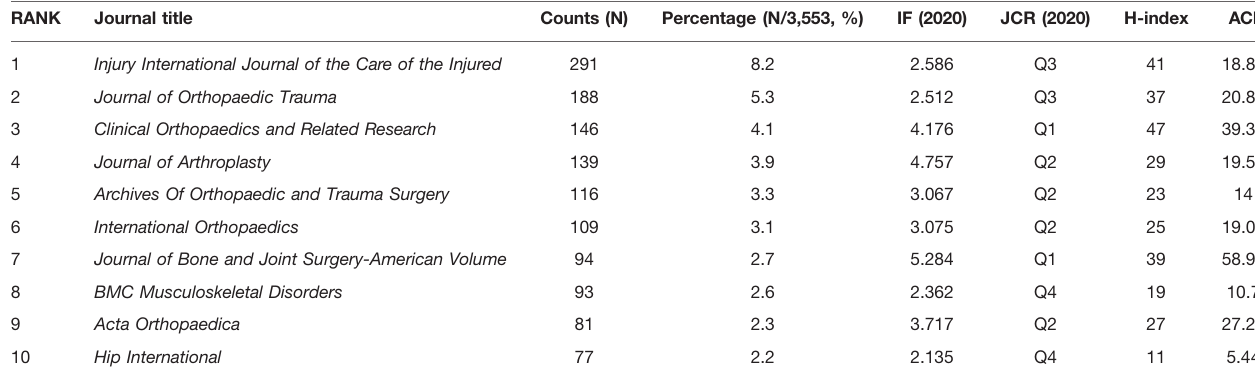
TABLE 3 | The top 10 journals with the most publications in FNF